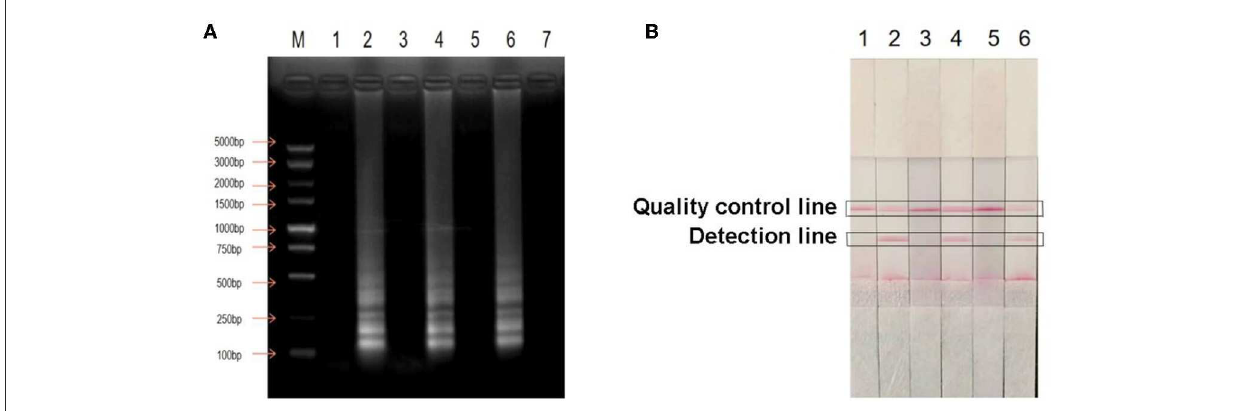
Clinical sample detection by